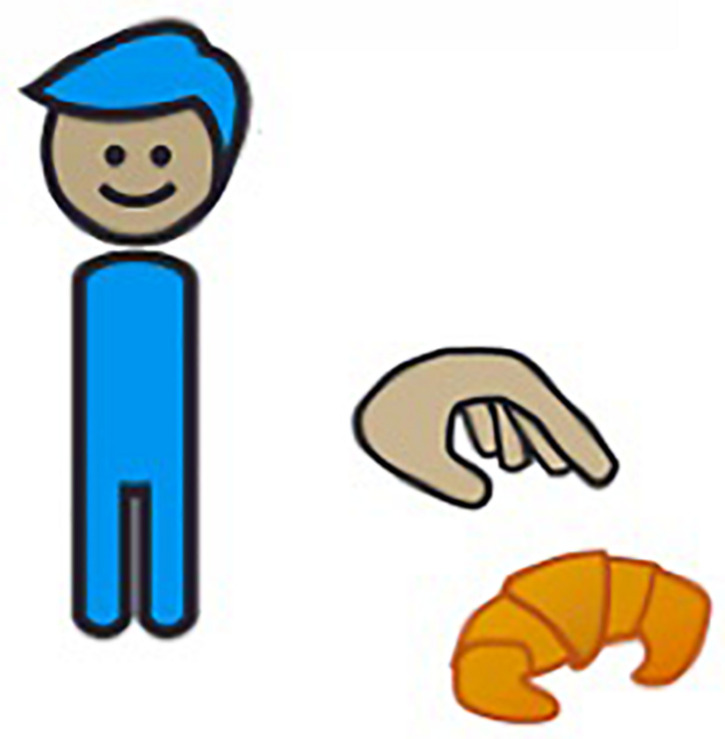
Illustration corresponding to the example item in (5).